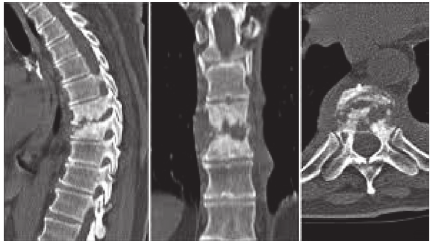
Figure 2: CT thoracic spine shows T10 vertebral body